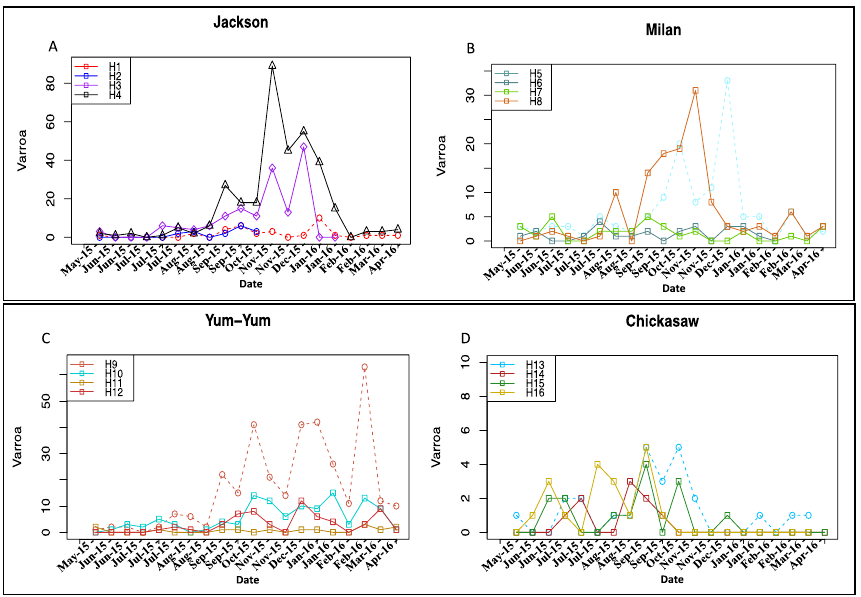
Figure 1. Number of varroa mite exposed per colony and date for each of the sixteen studied colonies. Varroa loads were biweekly counted using sticky mite board fixed at the bottom hive. ( A ) Group colonies of Jackson; ( B ) for those of Milan; ( C ) Yum-Yum; and ( D ) for colonies of Chickasaw.